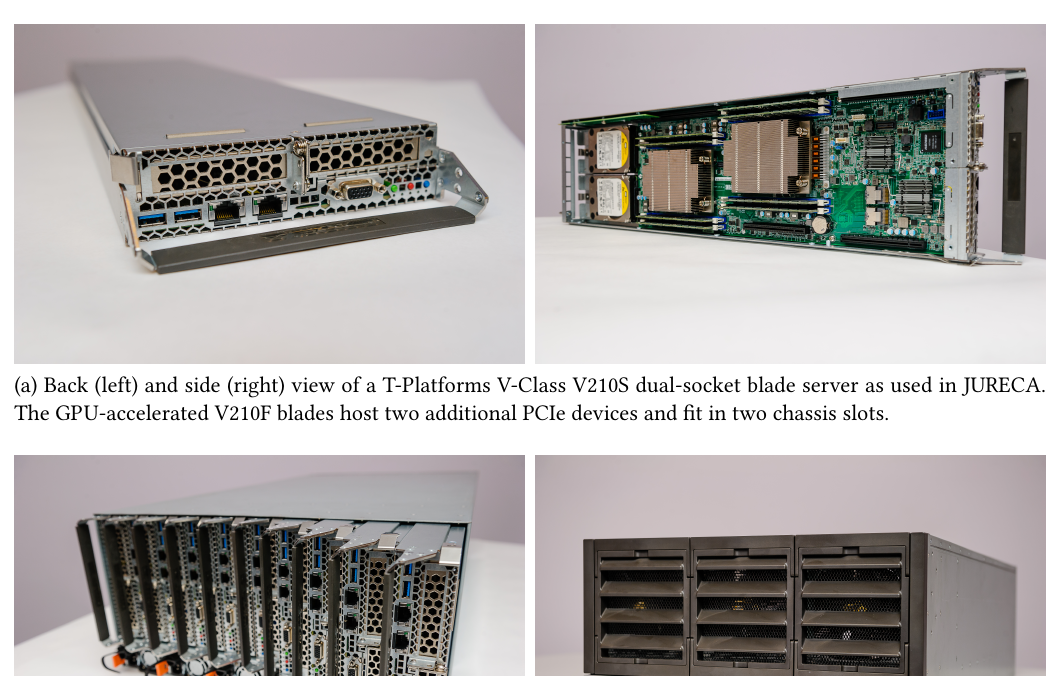
The JURECA compute nodes are connected with the industry-leading Mellanox extended data rate (EDR) InfiniBand providing 100 Gb/s (12.5 GB/s) link bandwidth and MPI latencies around one